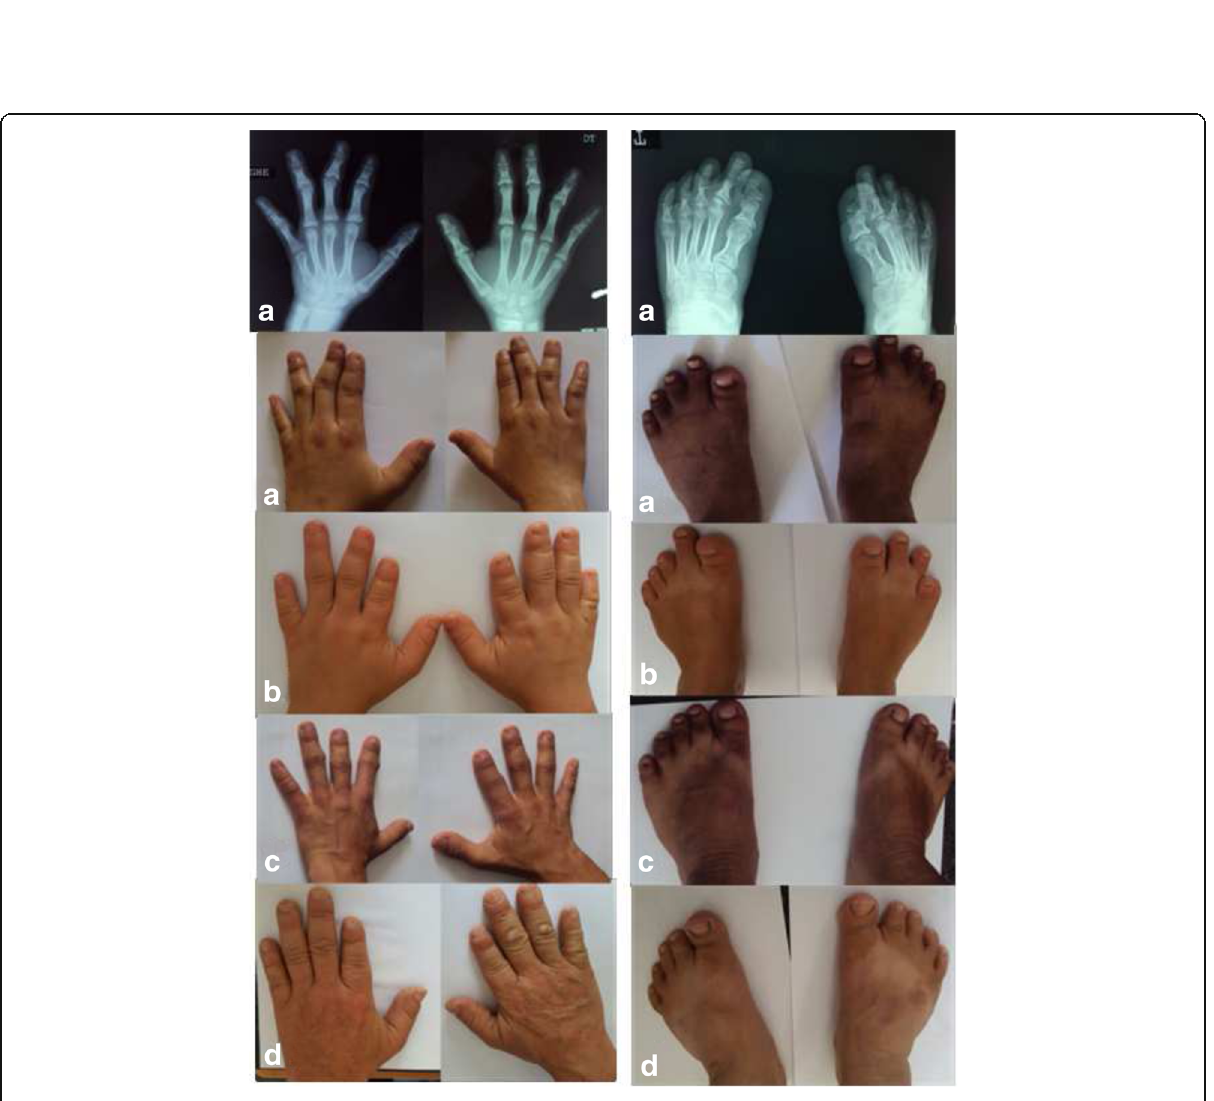
Fig. 3 Characteristic hands and feet disclosing severe brachydactyly with syndactyly in the family members. a - Proband, b - Sister, c - Brother, d - Father. X-rays of the proband show misalignment of the middle and distal phalanges predominant at the third and fourth fingers with cone shaped epiphyses in hands and